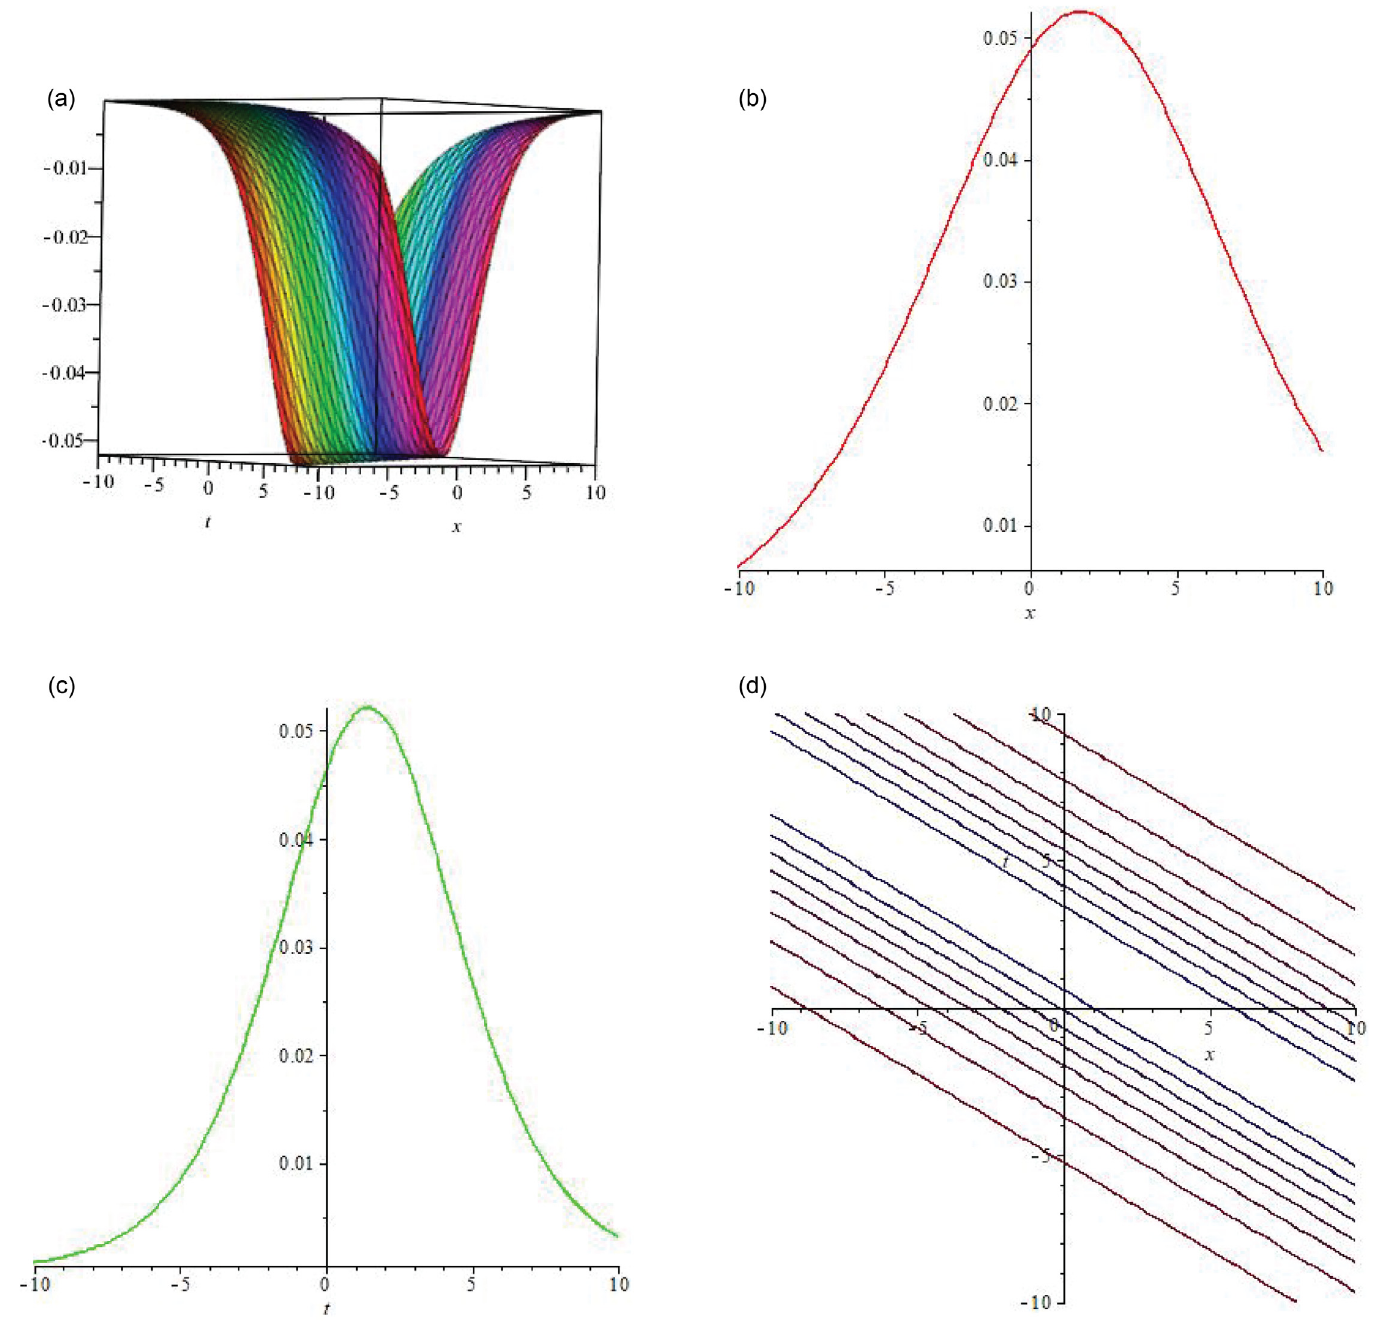
Fig 2. (a) is 3D solitary wave graph of | R ( x , t )|, (b) is 2D line graph with the variation in x, (c) is 2D line graph with the variation in t, (d) is the 2D contour